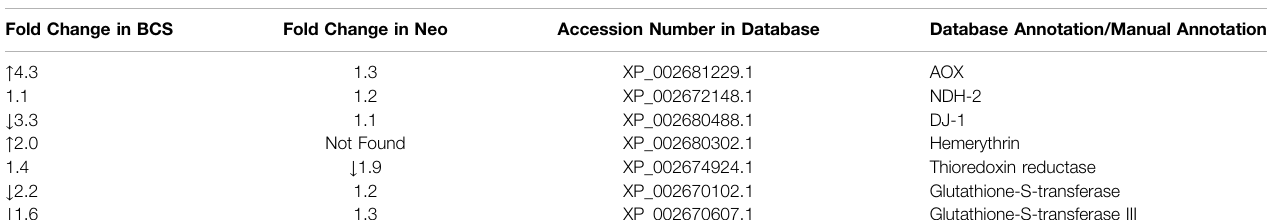
TABLE 1 | Selected N. gruberi and N. fowleri proteins whose abundance was signi fi cantly changed under copper-limited conditions in at least one condition and in one amoeba. Arrows indicate signi fi cant upregulation or downregulation, and no arrow sign in proteins with a fold change lower than 1.5 indicates no signi fi cant change. Naegleria gruberi Fold Change in BCS Fold Change in